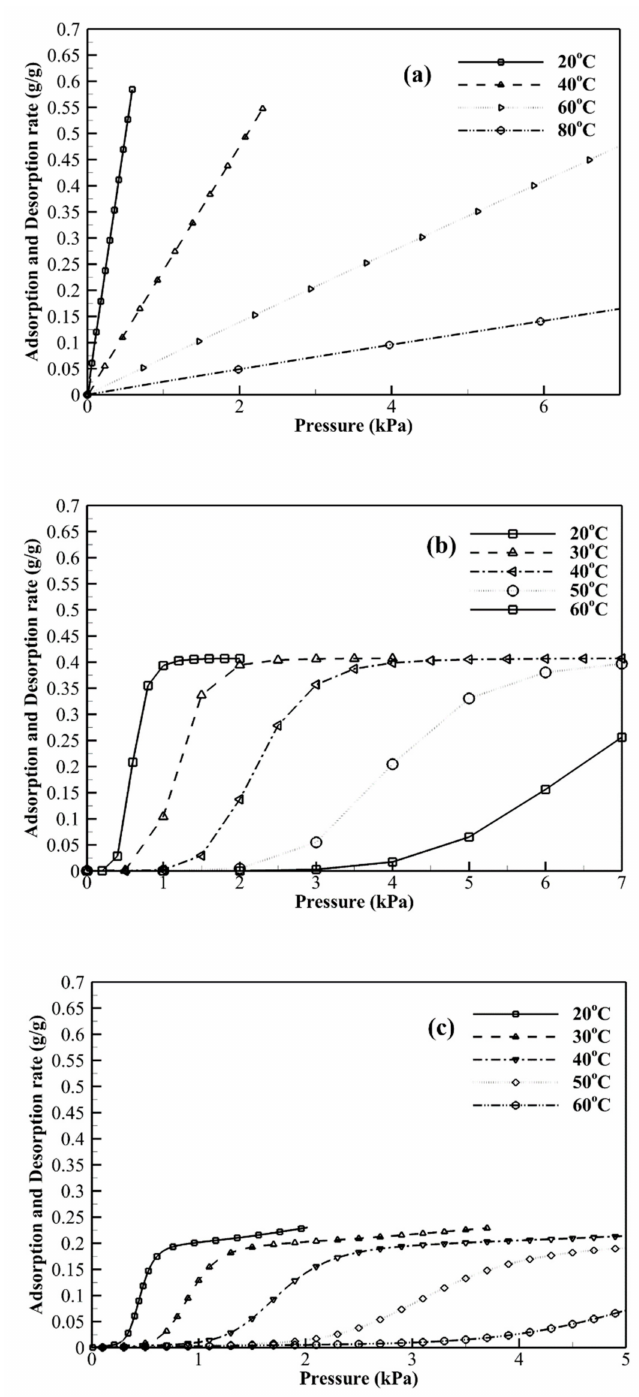
Figure 2. Isotherm characteristics of adsorbents according to the saturation pressure, such as: ( a ) silica-gel [2]; ( b ) aluminum fumarate [22], and ( c ) FAM-Z01 [18] at various